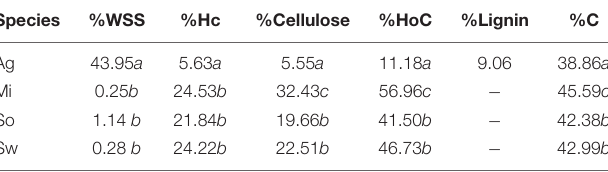
TABLE 1 | Composition analyses from experimental and literature values for dry untreated biomass for A. americana (Ag), M. x giganteus (Mi), S. bicolor (So) , and P. virgatum (Sw) . Water soluble saccharides (WSS), hemicellulose (Hc), cellulose, holocellulose (HoC), lignin, and carbon (C) are reported as a percentage of dry